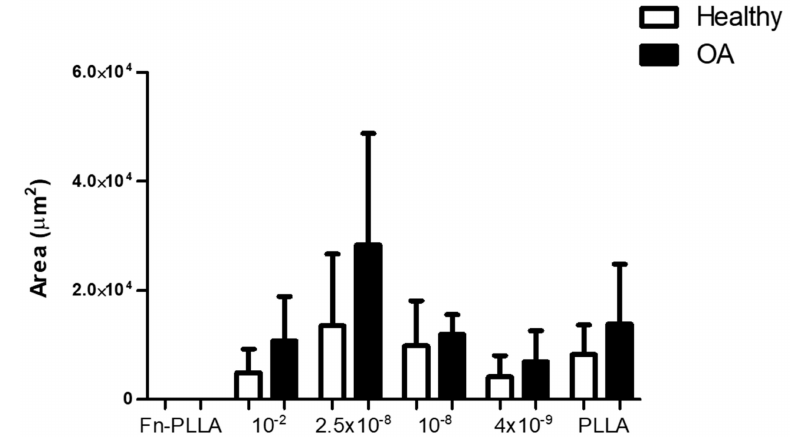
Figure 3. Area (units) of healthy- (H) and osteoarthritic (OA)-derived BM-MSC aggregates formed in RGD-Cys-D1 PLLA nanopatterned substrates (10 − 2 , 2.5 × 10 − 8 , 10 − 8 , and 4 × 10 − 9 ), fibronectin-coated PLLA (Fn-PLLA), or untreated PLLA (PLLA) after three days, under chondrogenic medium (CM). Values are given as the mean of at least three aggregates with standard deviation.